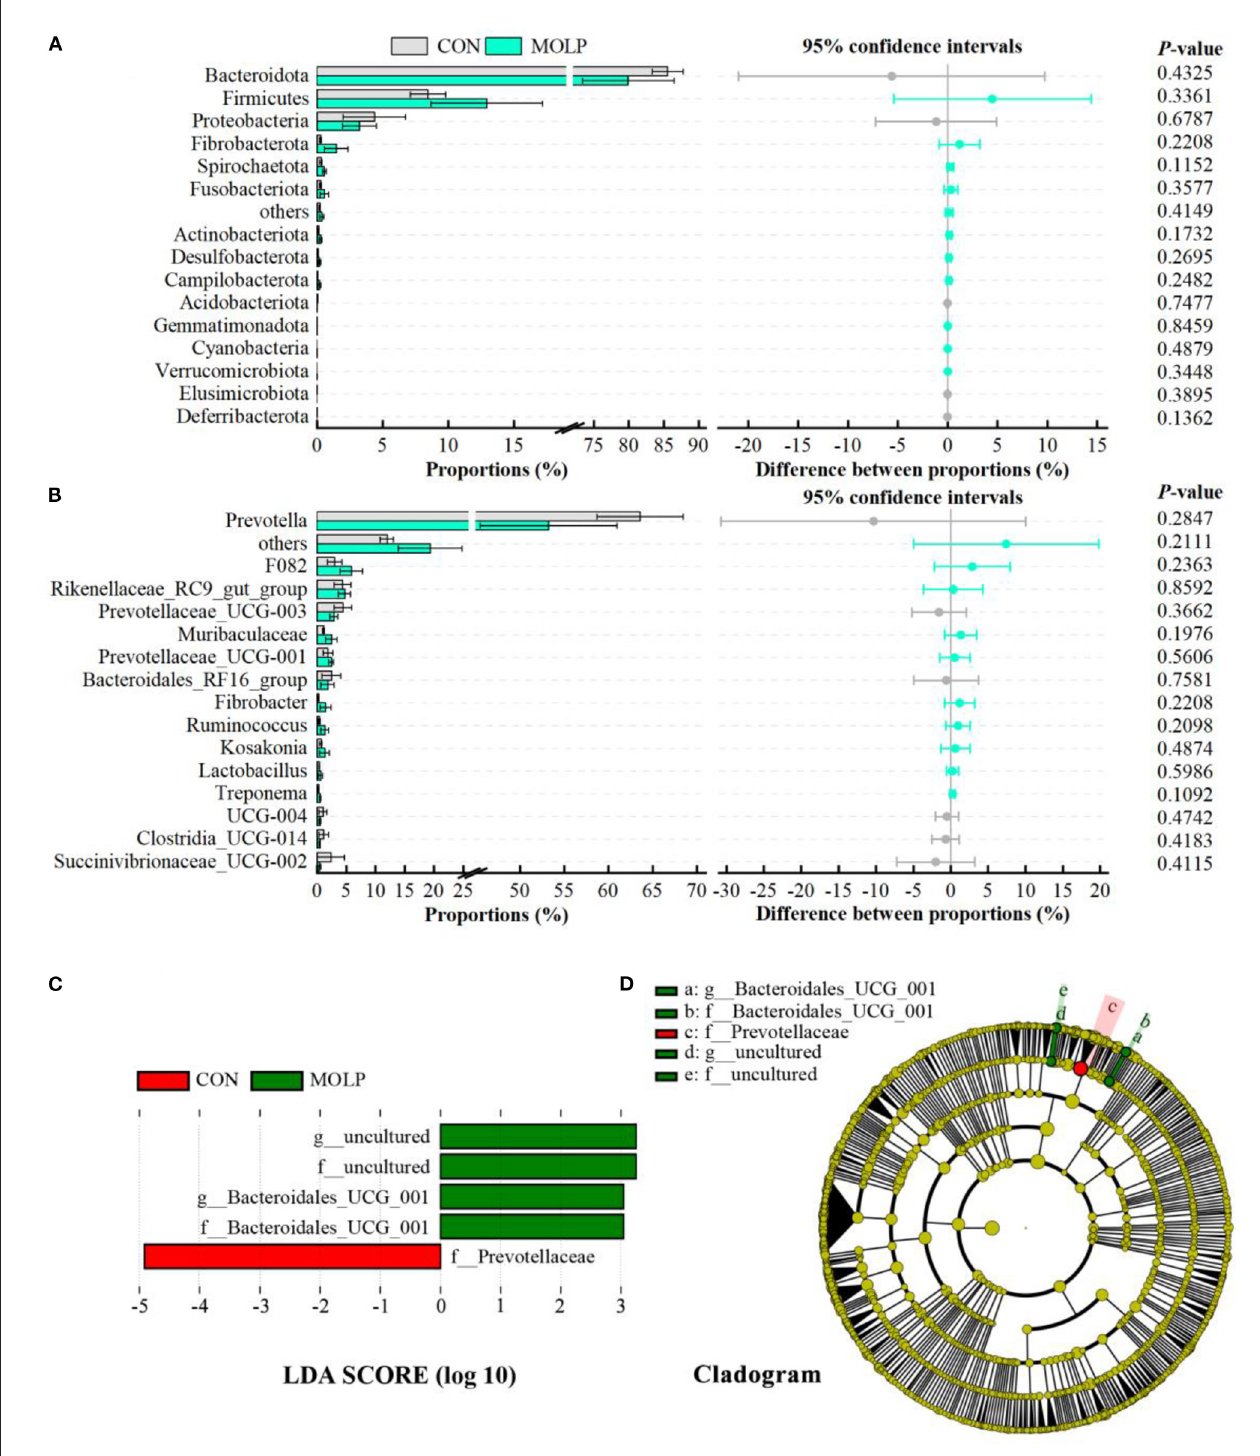
FIGURE4 Effects of MOLP on the rumen microbial composition. The difference between bacterial phyla (A) and genera (B) was tested by the Student’s t -test. The top 15 microbes’ average abundance was compared. The values in the histogram are the mean values of relative abundance ± SEM. (C) Linear Discriminant Analysis (LDA) coupled with effect size (LEfSe) measurements identifies the most differentially abundant taxa between CON and MOLP groups. Taxa enriched in the MOLP group are indicated with a positive LDA score (green), and taxa enriched in the CON group have a negative score (red). Only taxa with an LDA score of > 3 and a P value of < 0.05 are shown. (D) Cladogram for rumen microbiota (CON group vs. MOLP